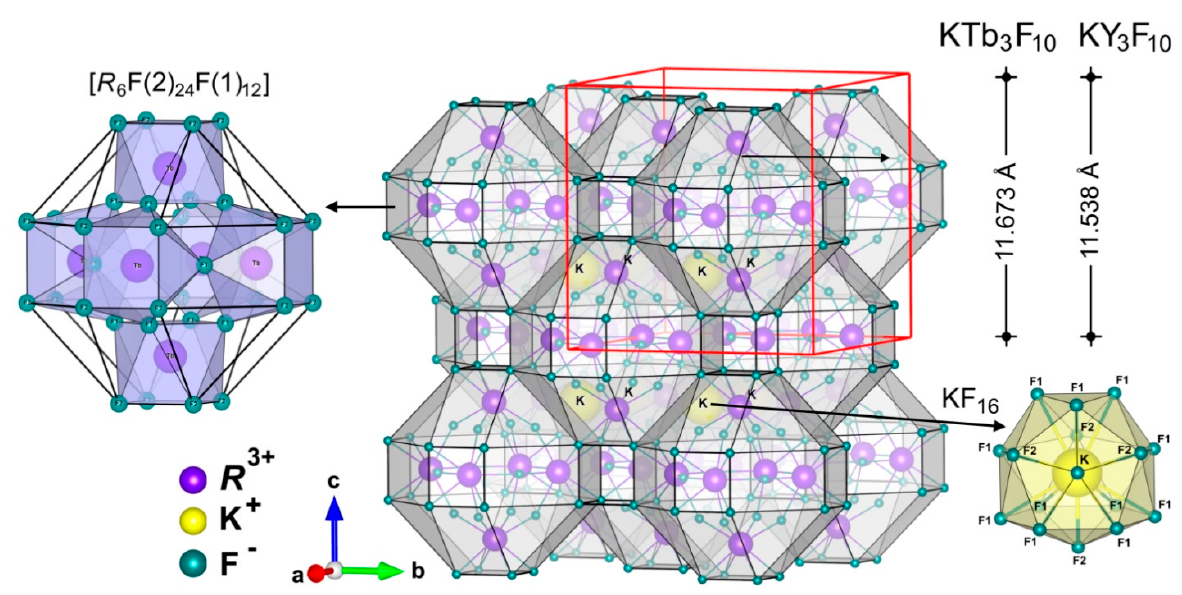
Figure 7. Geometry of the polyanionic cluster [ R 6 F 36 ] ( left ), the crystal structure of K R 3 F 10 ( R = Tb 3+ , Y 3+ ) as a three-dimensional assembly of [ R 6 F 36 ] clusters ( center ), and KF 16 -polyhedron ( right ).